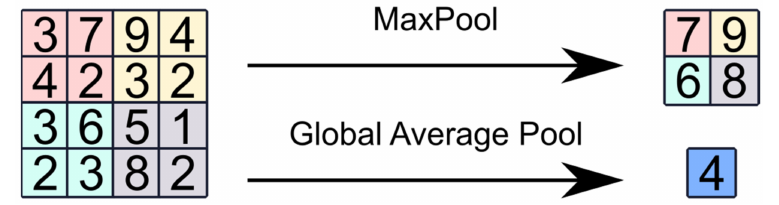
Figure 3. Pooling operations in